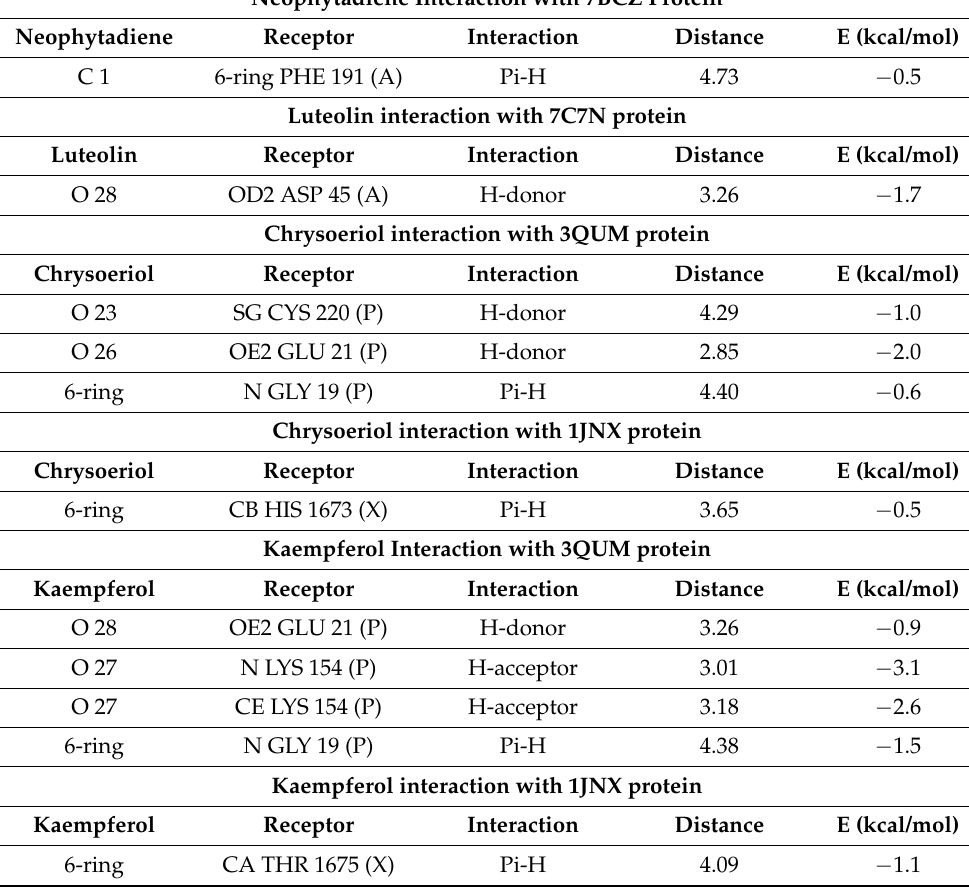
Table 8. Interaction of active compounds with proteins.